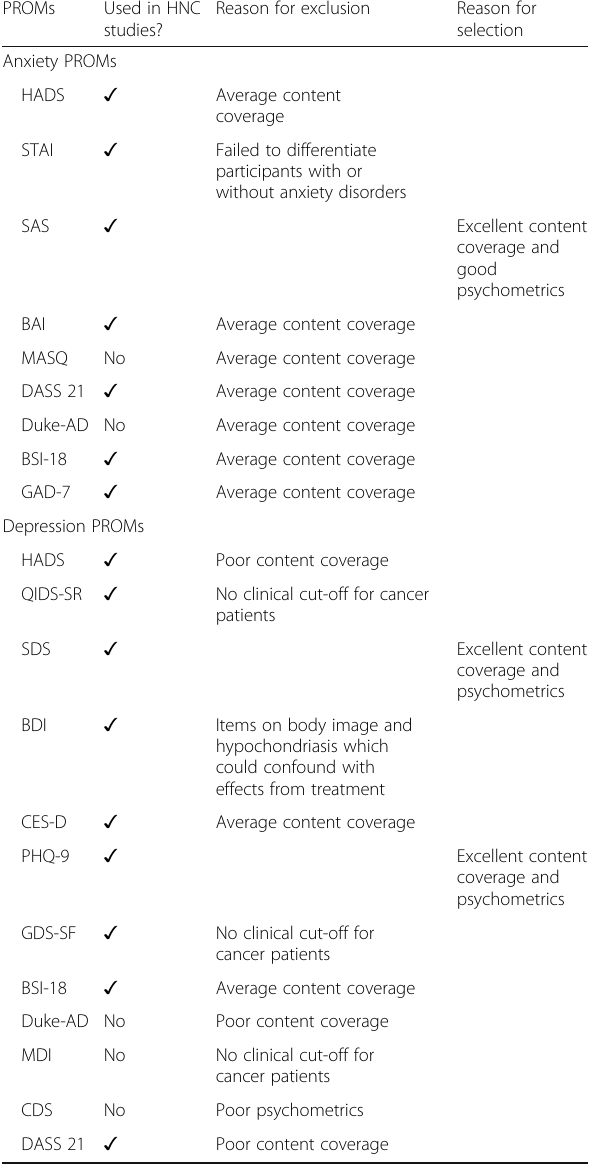
Table 5 PROMs used in HNC studies, reasons for inclusion and